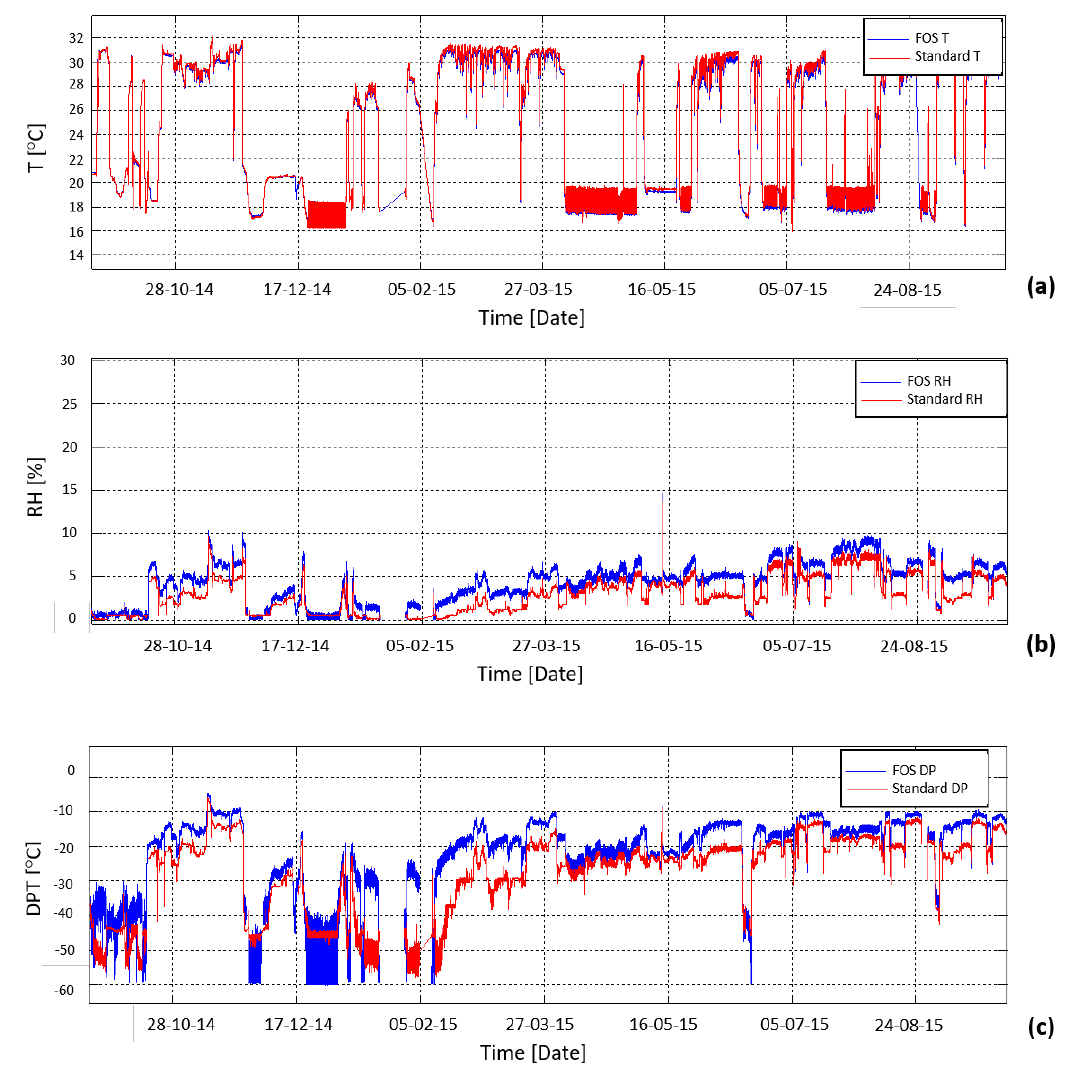
Figure 27. Temperature ( a ), relative humidity ( b ) and dew point ( c ) reconstruction from the FBG- based thermo-hygrometer installed in on the CMS Tracker end-flange. For comparison, the readings from the standard hygrometer installed in the same position are reported in red